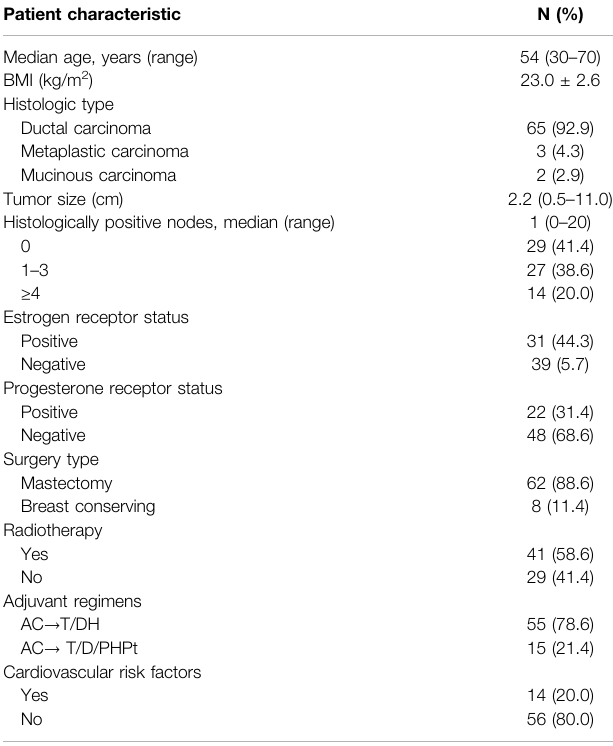
TABLE 1 | Patients baseline characteristics (N =